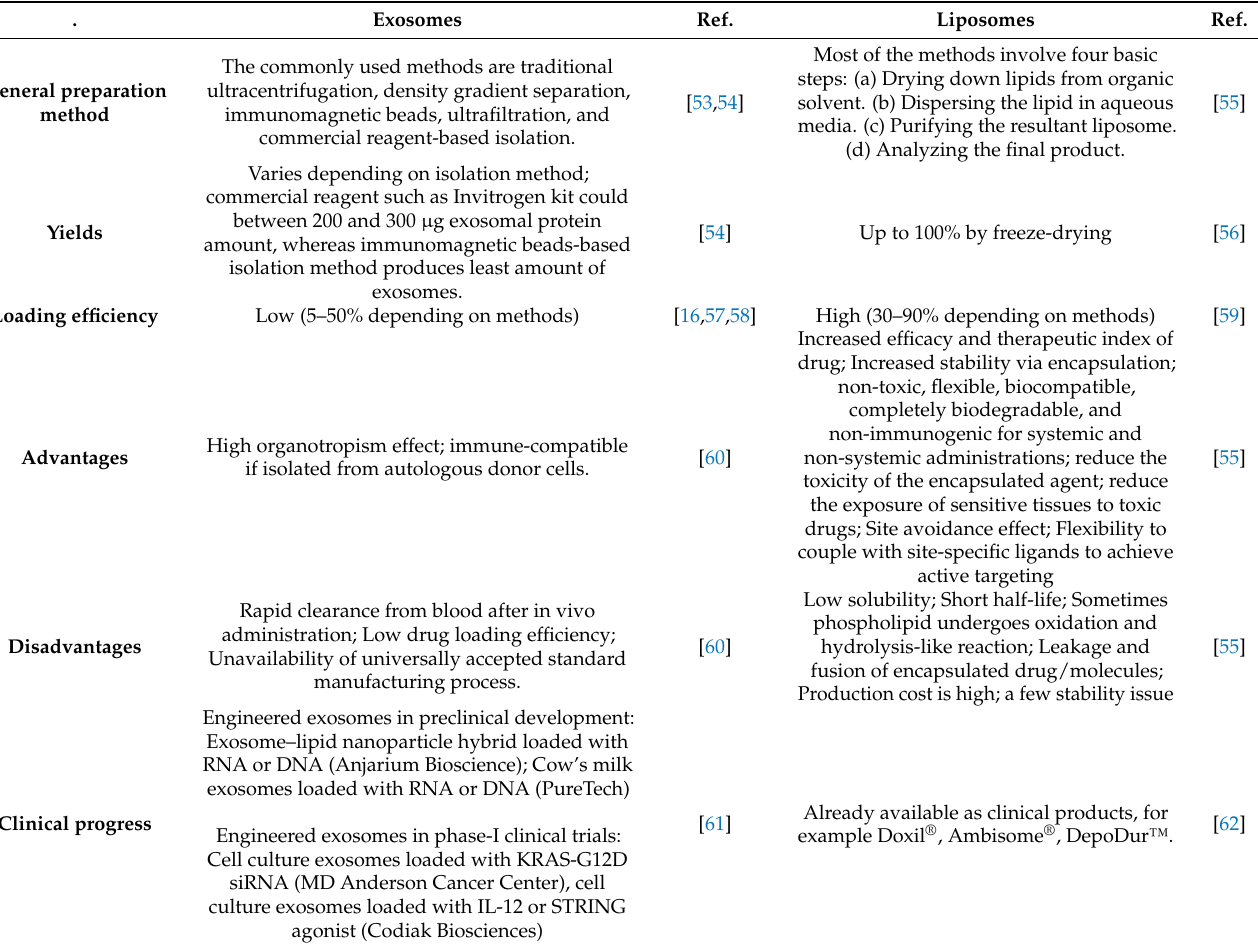
Table 1. Comparison between exosomes and liposomes for DDS application. . Exosomes Ref. Liposomes